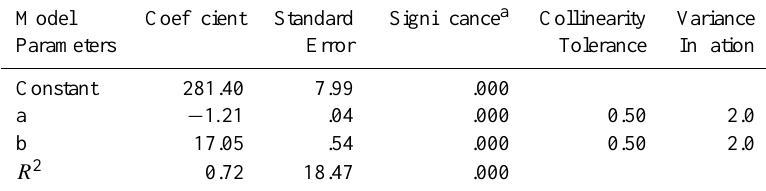
Table 1. Multiple regression and error analysis results from using GLASH and PV together to explain variance in the dependent variable of TES observed ozone in the UT, based on the training data set (75% of data) . Collinearity tests evaluate the independence of the predictors.